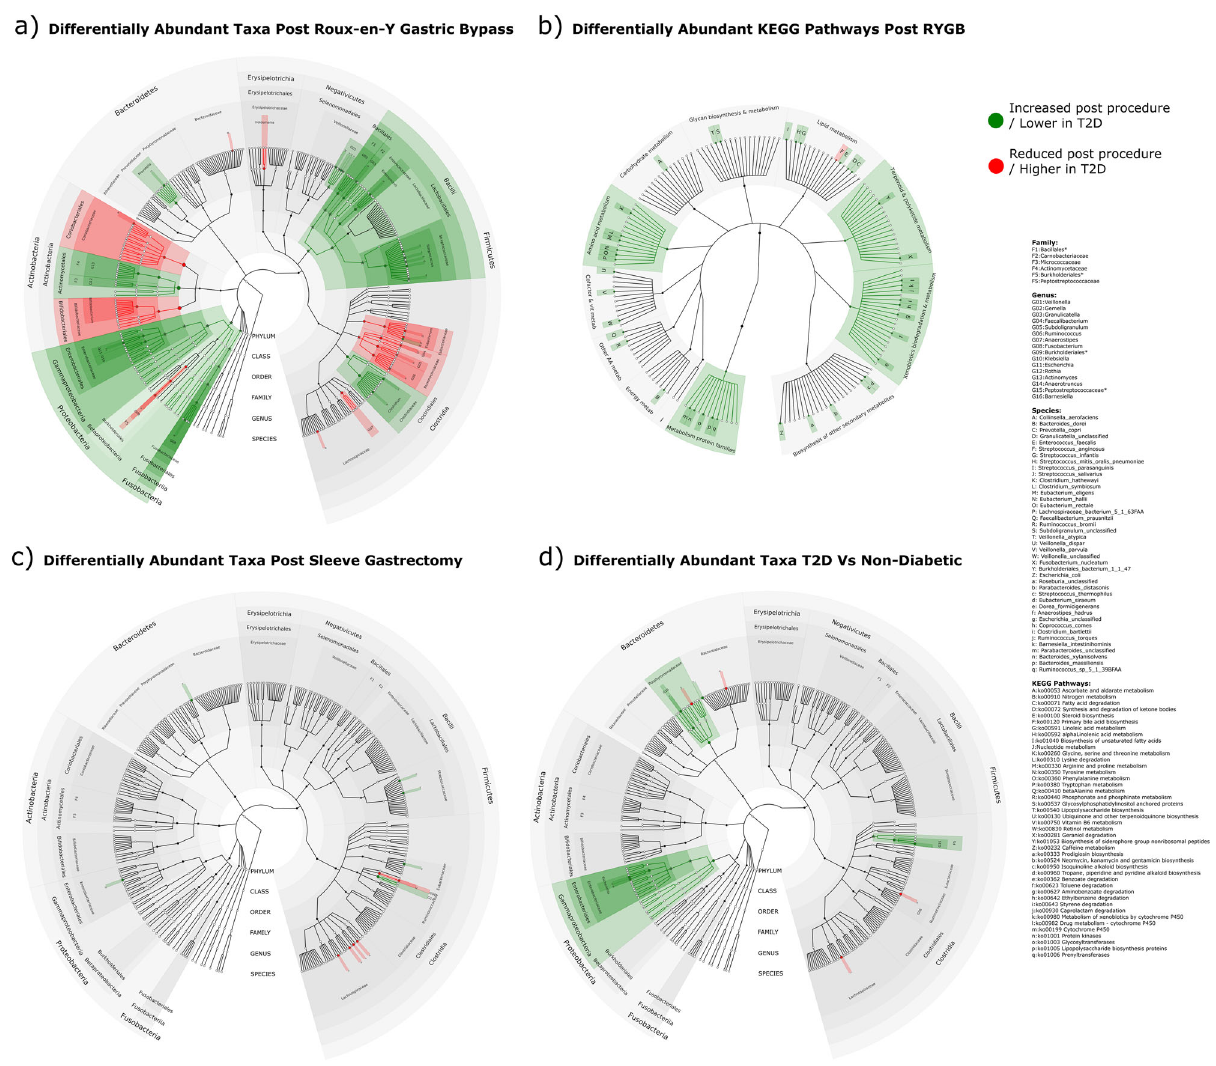
Fig. 3 Gut microbiota changes after bariatric surgery and in participants ± T2D. a Phylogenetic tree of signi fi cant differentially abundant taxa from phyla to species 3-months post Roux-en-Y Gastric Bypass (RYGB) ( n = 13). b Phylogenetic tree of signi fi cant differentially abundant level 2 and level 3 Kyoto Encyclopaedia of Genes and Genomes (KEGG) pathways 3-months post RYGB ( n = 13). c Phylogenetic tree of signi fi cant differentially abundant taxa from phyla to species 3-months post Vertical Sleeve Gastrectomy (VSG) ( n = 14). d Phylogenetic tree of signi fi cant differentially abundant taxa from phyla to species between participants with type 2 diabetes (T2D) ( n = 42) vs participants without diabetes ( n = 27). Taxa / KEGG pathways signi fi cantly ( p < 0.05) increased post-surgery ( a – c ) or lower in participants with T2D vs participants without diabetes ( d ) are shown in green, taxa / KEGG pathways signi fi cantly ( p < 0.05) decreased post-surgery ( a – c ) or higher in participants with T2D vs participants without diabetes ( d ) are shown in red. Changes that remain signi fi cant after Benjamini-Hochberg multiple testing corrections (pFDR < 0.05) are denoted with an asterisk (*). Plots ( a – d ) are shown individually in Supplementary Figs. 12, 14, 15 and